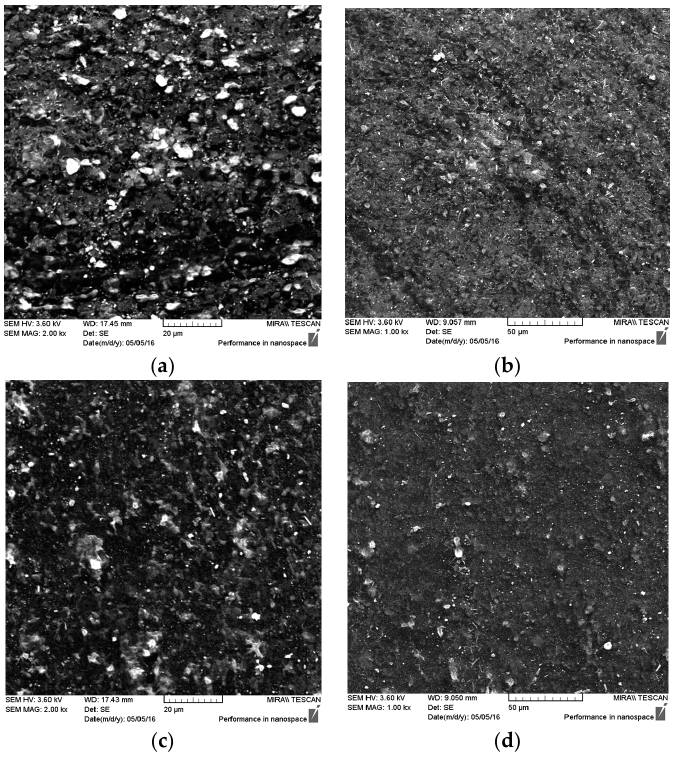
Figure 7. Scanning electron micrographs of conductive dry films: ( a,b ) 15% PEDOT:PSS A/C dry film and ( c,d ) 8% PEDOT:PSS B/C dry